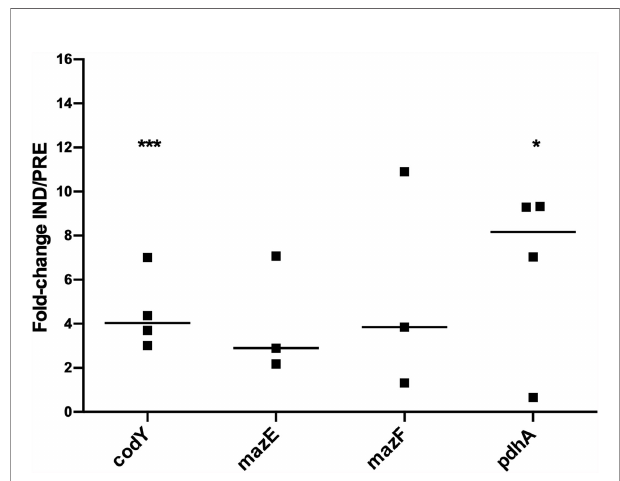
FIGURE 4 | Expression of the genes of interest in 48 h-old planktonic populations of S. epidermidis 1457 grown under induced and prevented VBNC conditions. Data is presented as the fold-change between the induced (IND) and the prevented (PRE) VBNC conditions (IND/PRE). Data is represented as the fold-change of the individual assays, where the horizontal lines represent the median of at least three independent experiments. * p < 0.05, *** p < 0.001 (Unpaired Welch ’ s